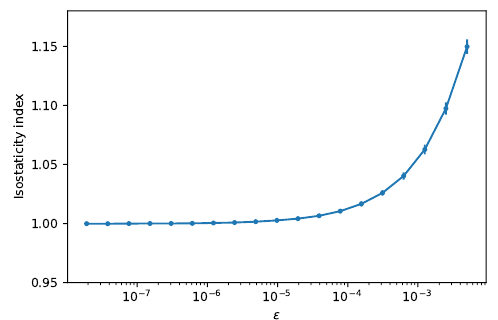
Figure 8: The behavior of the isostaticity index as a function of the regularizer pa- rameter ε for a system of N = 2048 spheres in d = 2 at φ = 2, averaged over 29 samples. For ε → 0 the system sits in an isostatic